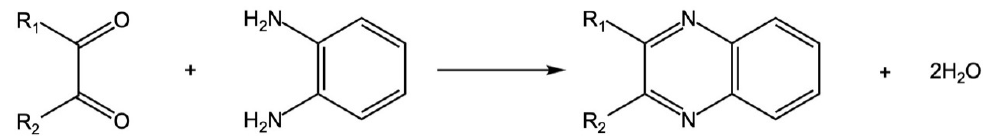
Figure 1. The reaction equation of OPD and α